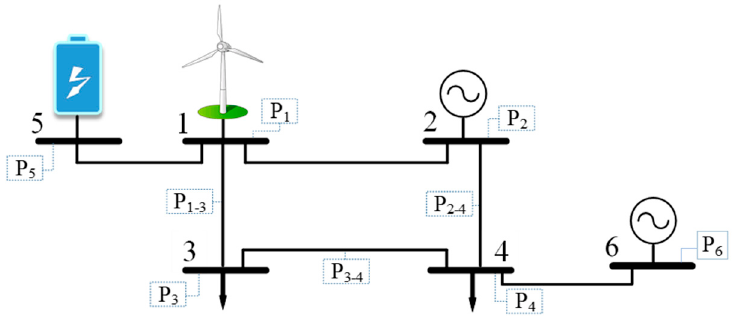
Figure 5. Test scheme.